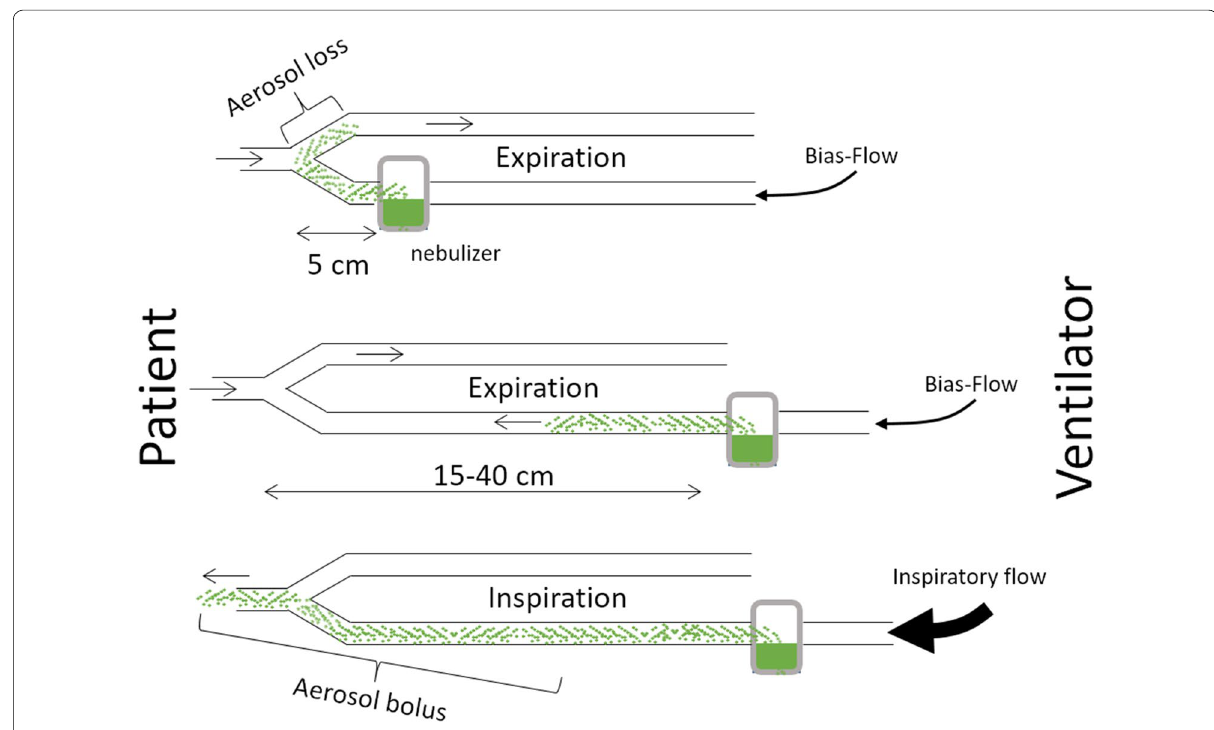
Fig. 1 Influence of the nebulizer position on aerosol losses during expiration. Nebulizer positioning upstream in the inspiratory limb enables the latter to act as a spacer/reservoir, thereby storing aerosol during expiration for an aerosol bolus delivery at the next